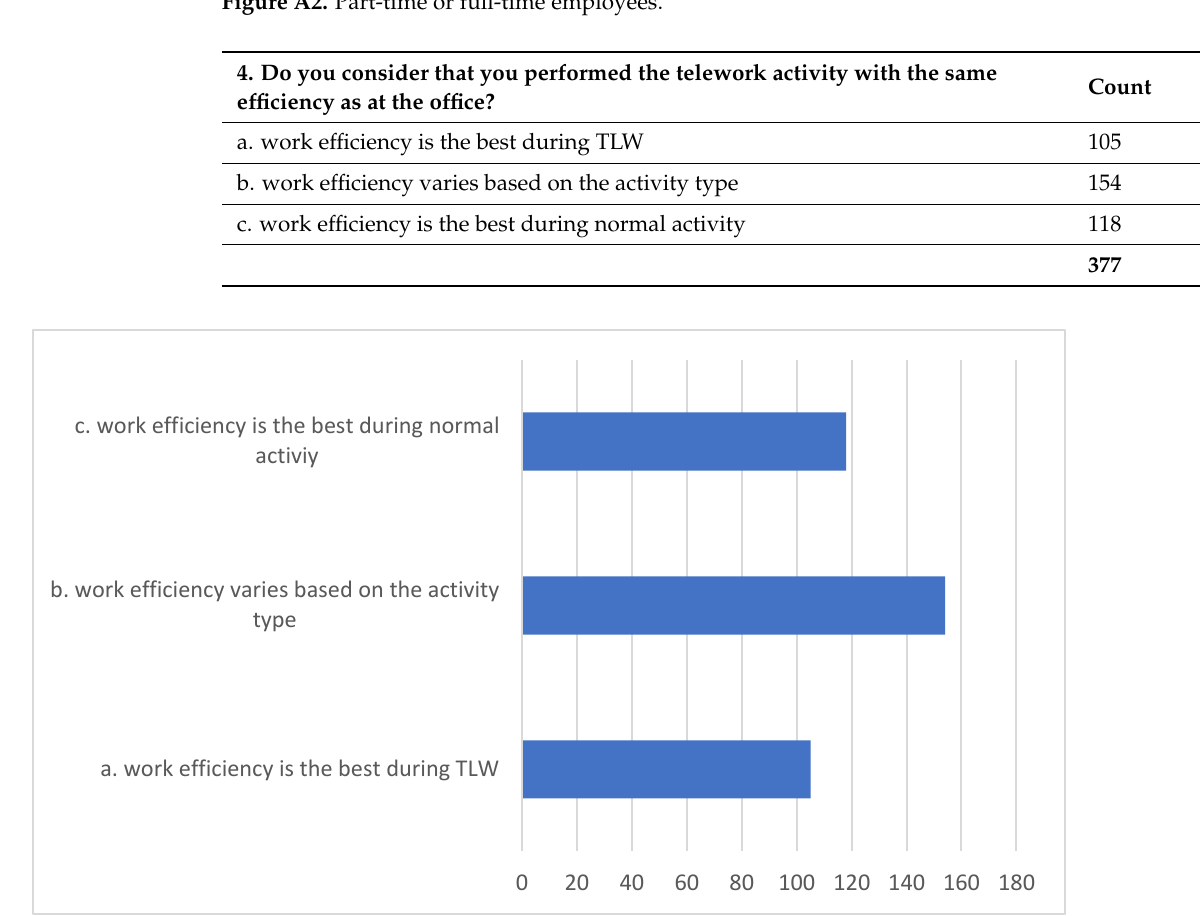
Figure A3. Efficiency of teleworking activity vs. office efficiency. 5. Do you consider that your employer has made a sustained effort to facili ‐ tate your telework activity?